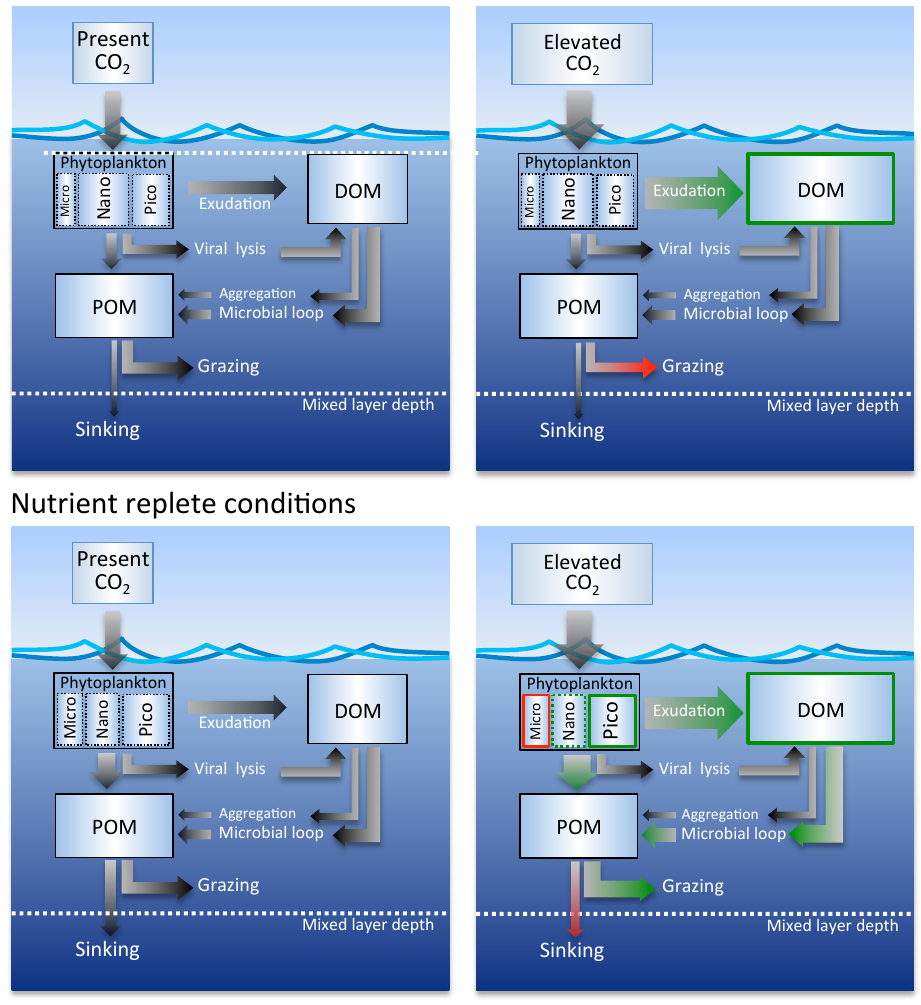
Fig. 2. Sketch of carbon pools and fluxes at present day ( left panels ) and elevated CO 2 levels ( right panels ) under nutrient-limiting ( upper panels ) and nutrient-replete conditions ( lower panels ). The sizes of the boxes represent pool sizes, the thickness of the arrows represent the magnitude of the fluxes between pools; green arrows indicate fluxes stimulated by elevated CO 2 , red arrows fluxes which are reduced at elevated CO 2 . POM, particulate organic matter, DOM, dissolved organic matter. With a depth of 17m, the water body enclosed in the mesocosms was entirely in the euphotic zone. Note that some of the fluxes were not measured directly but calculated or inferred from other measured parameters. Modified from Arrigo (2007) according to the outcome of this